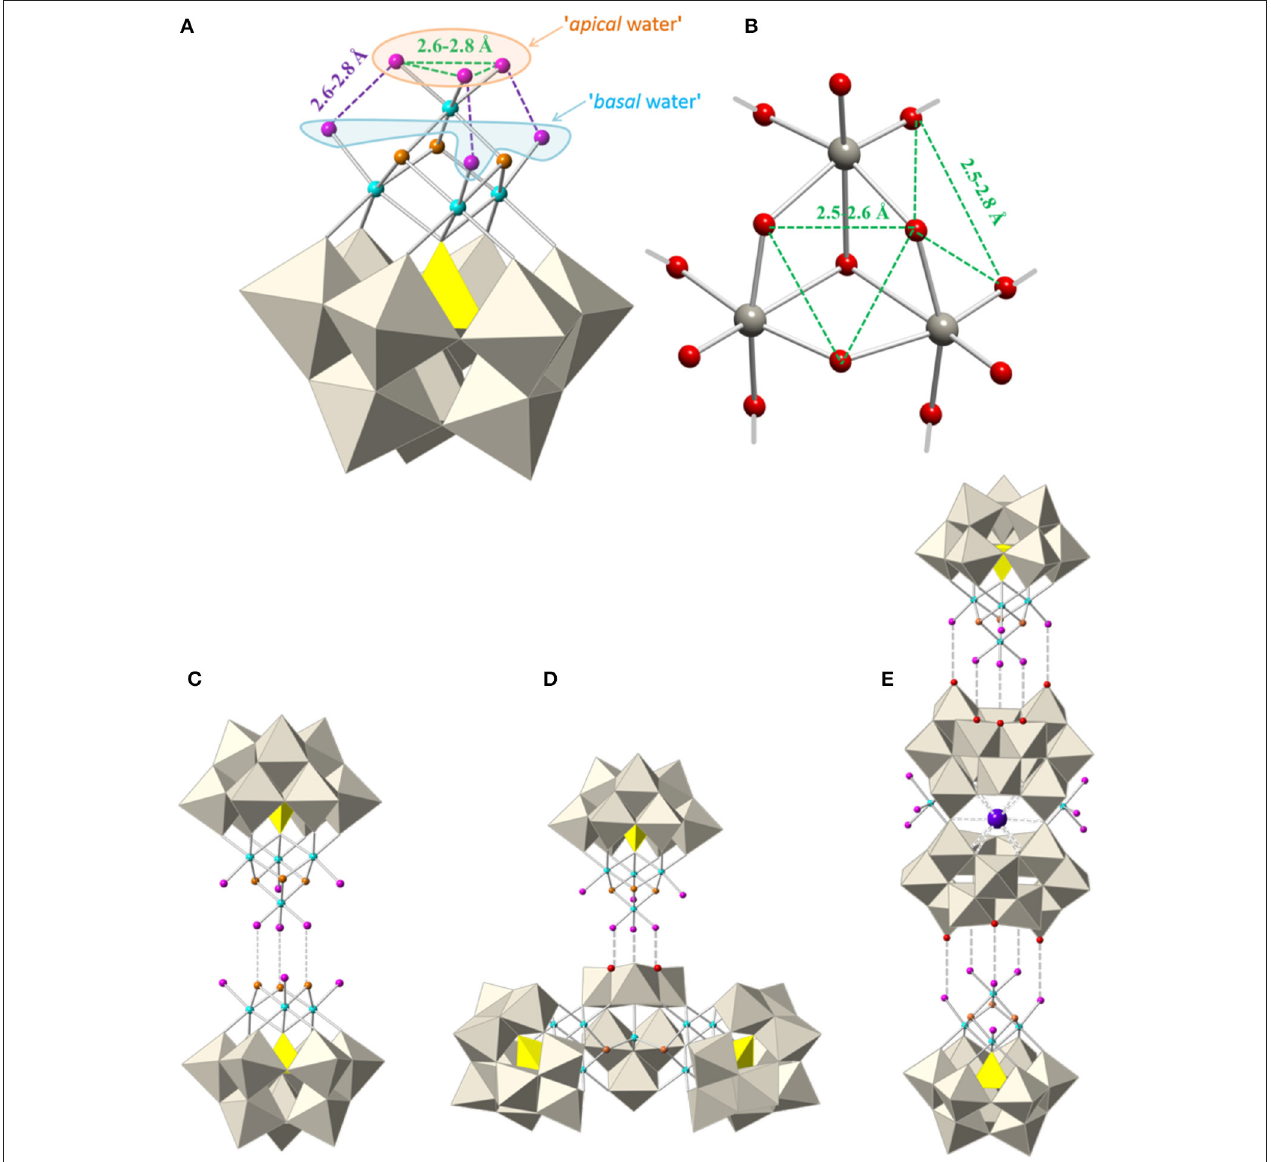
FIGURE 1 | (A) Polyhedral and ball-and-stick representation of the polyoxoanion [Co II 4 (OH) 3 (H 2 O) 6 (PW 9 O 34 )] 4 − ( 1 ) in which some mean distances between water molecules (pink spheres) have been indicated. (B) Ball-and-stick representation of an edge-shared {W 3 O 13 } group, with indication of some O ··· O distances to illustrate the possibilities of water substitution in 1 . Polyhedral and ball-and-stick representations of the assembling of polyoxoanions (C) [Co 7 (OH) 6 (H 2 O) 6 (PW 9 O 34 ) 2 ] 9 − ( 2 ); (D) [Co 11 (OH) 5 (H 2 O) 5 (W 6 O 24 )(PW 9 O 34 ) 3 ] 22 − ( 3 ) and (E) [{Co 4 (OH) 3 (H 2 O)(PW 9 O 34 )} 2 {K ⊂ (H 2 W 12 O 41 ) 2 }{Co(H 2 O) 4 } 2 ] 17 − ( 4 ). POM 2 ′ (not shown) is a polymeric chain made of units of 2 . (Grey octahedra, {WO 6 }; yellow tetrahedra, {PO 4 }; gray spheres, W; cyan spheres, Co II ; blue spheres, Co III ; red spheres, O; orange spheres, OH; pink spheres, H 2 O; violet sphere, K.